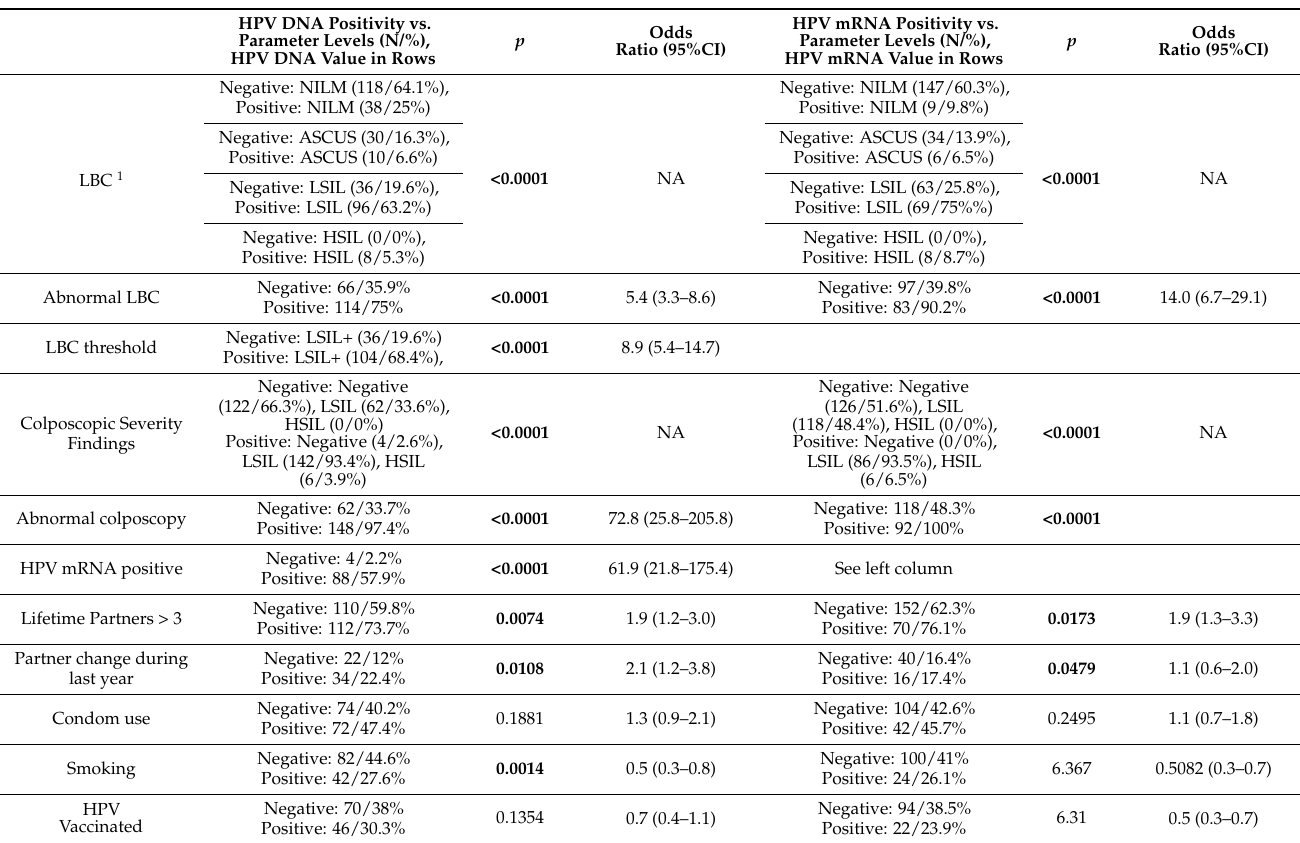
Table 2. Statistical comparisons of HPV DNA positive vs. negative result with all other recorded variables. Bold entries indicate statistical